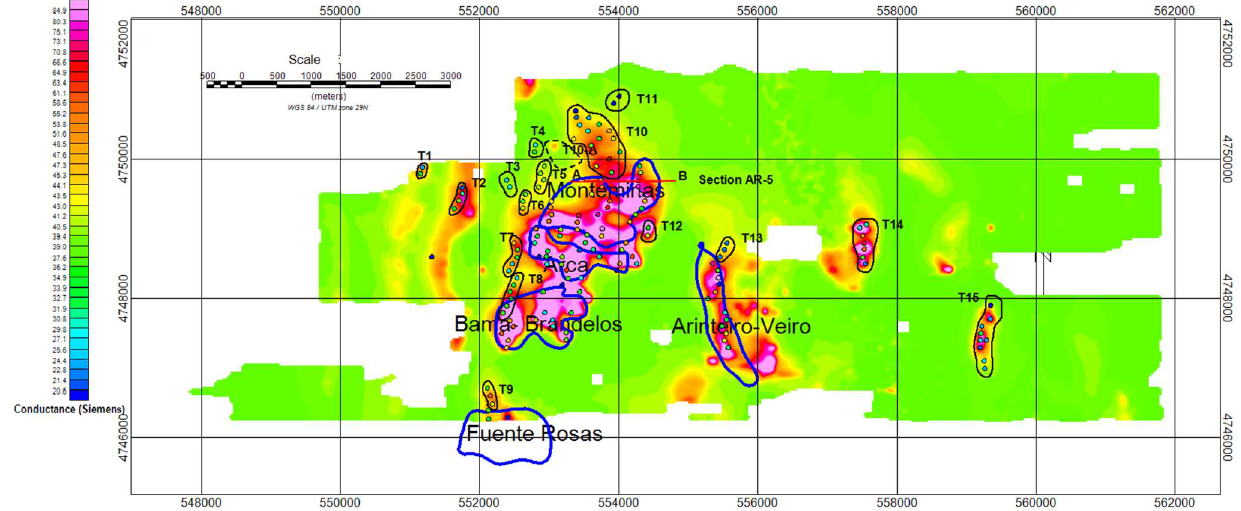
Figure 6. VTEM EM channel SFz25 (coloured background), known ore bodies (blue outlines). VTEM anomaly pick coloured symbols, with values > 20 Siemens, permitting the definition of additional areas of interest identified as targets T1 to T15 (black outlines). The cultural anomalies were not delineated.